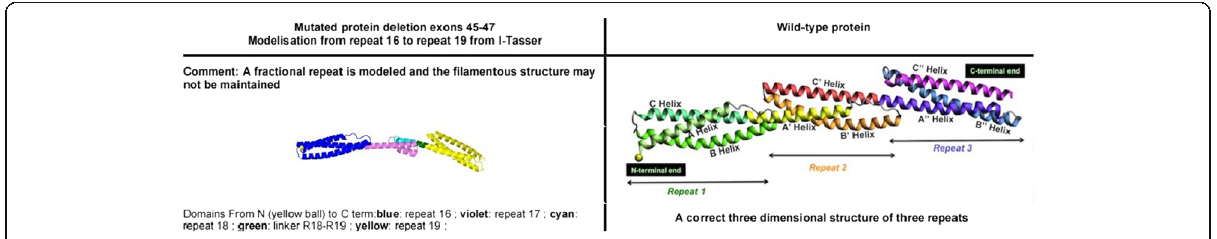
Fig. 6 3D- structure model of the mutation site of exon 45 – 47 deletion obtained from